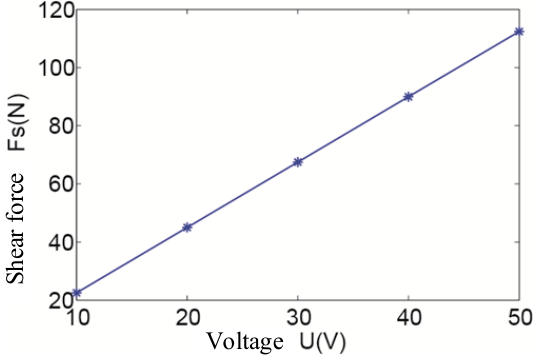
Figure 12. Influence of voltage on shear force.